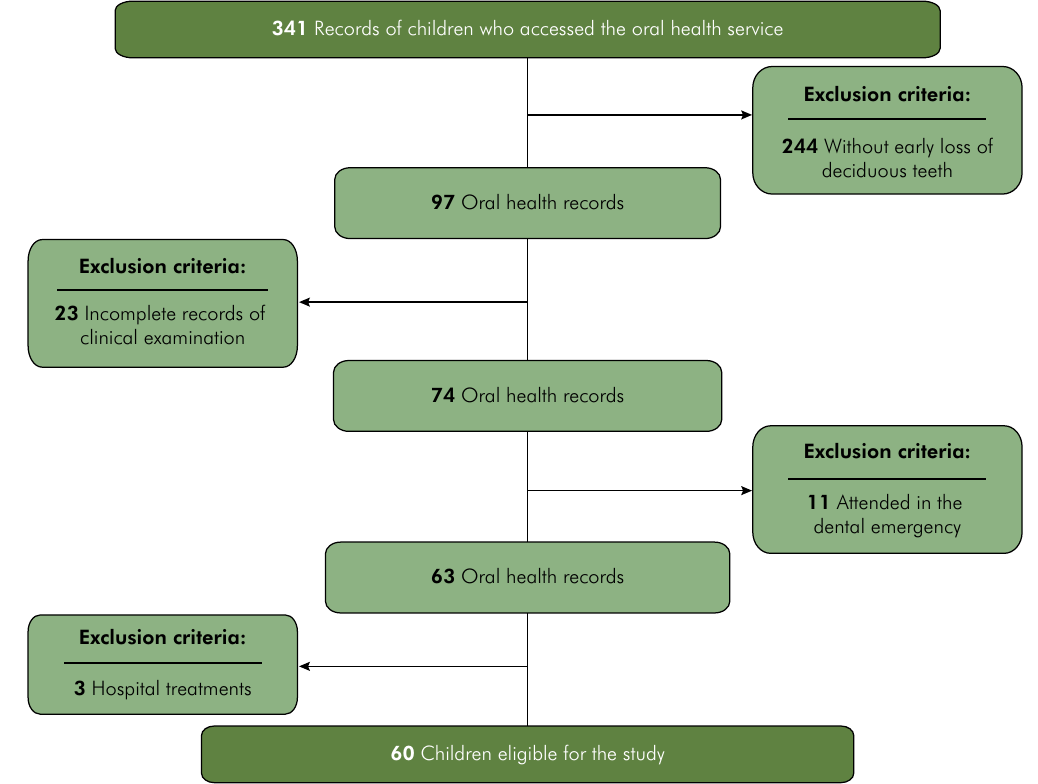
Figure. Criteria for selecting the sample of children who accessed the oral health service of the Faculty of Dentistry through the analysis of oral health